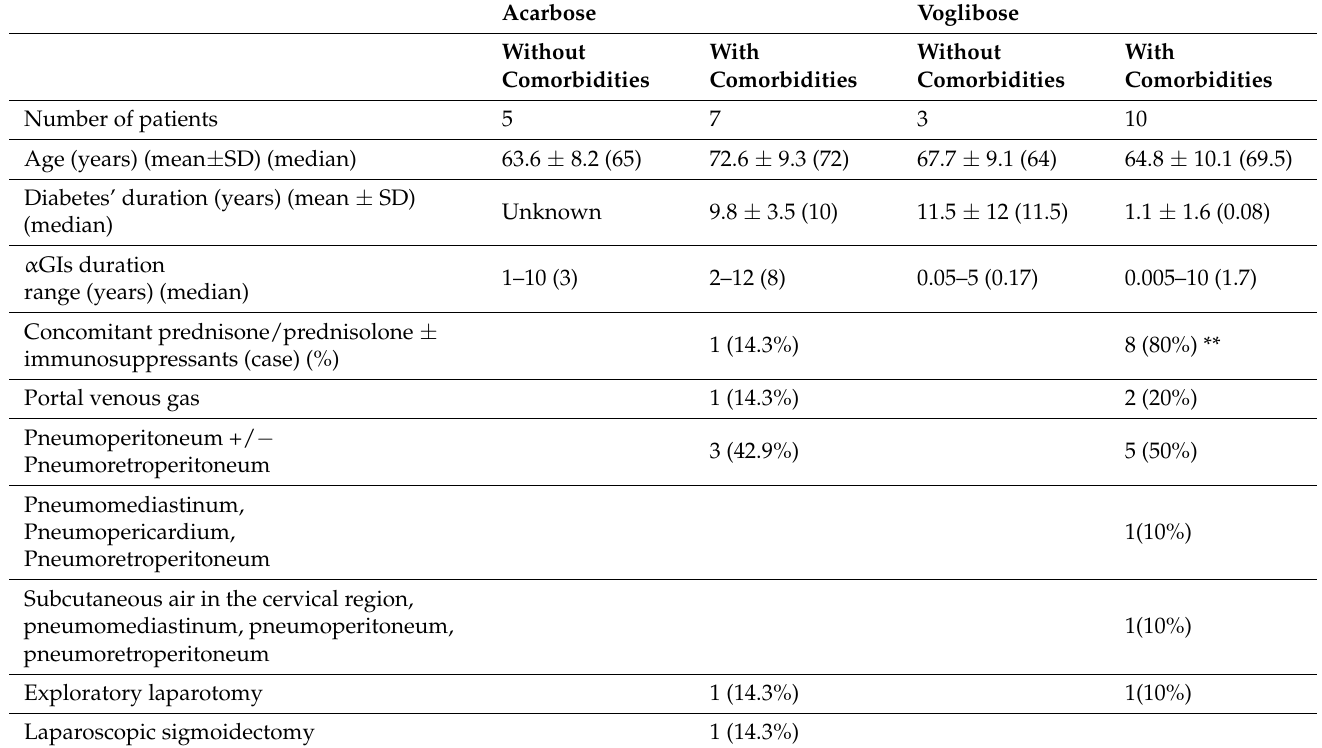
Table 4. Comparison between patients who used acarbose and patients who used voglibose.